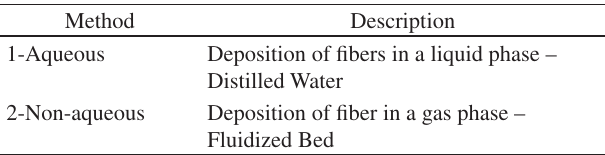
Table 1. Methods for the manufacturing of mats.